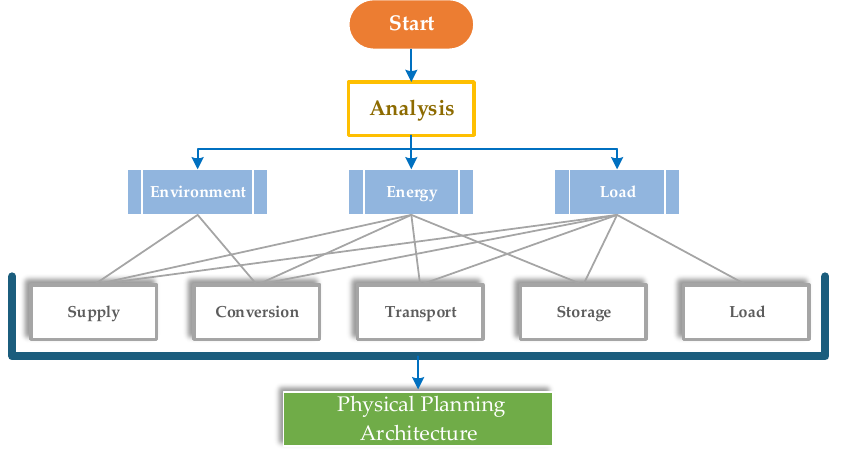
Figure 1. Construction flow of physical planning topology.